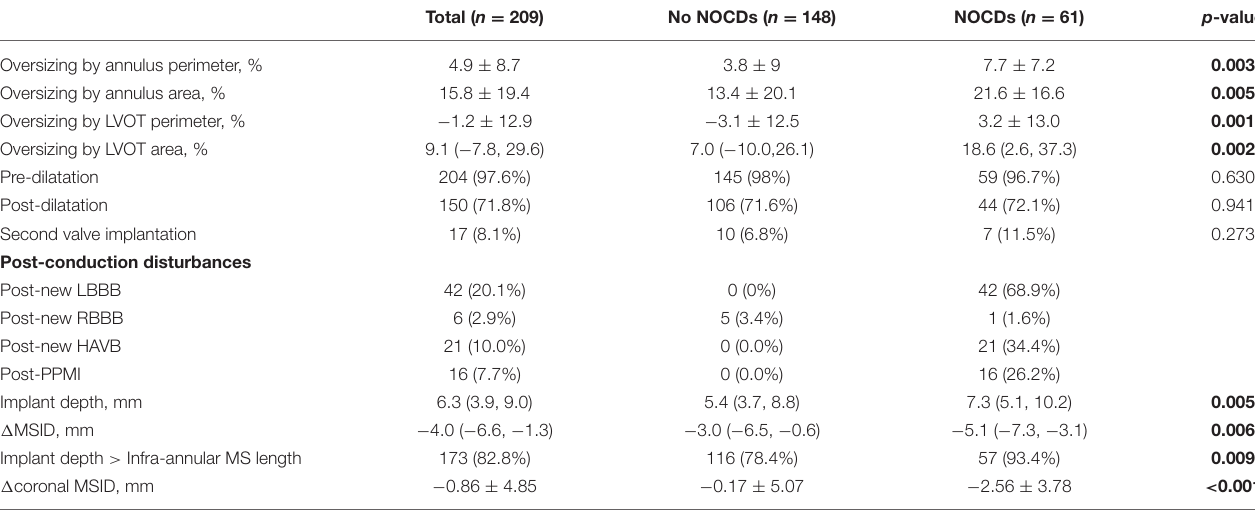
TABLE 3 | Procedural characteristics and conduction abnormalities.